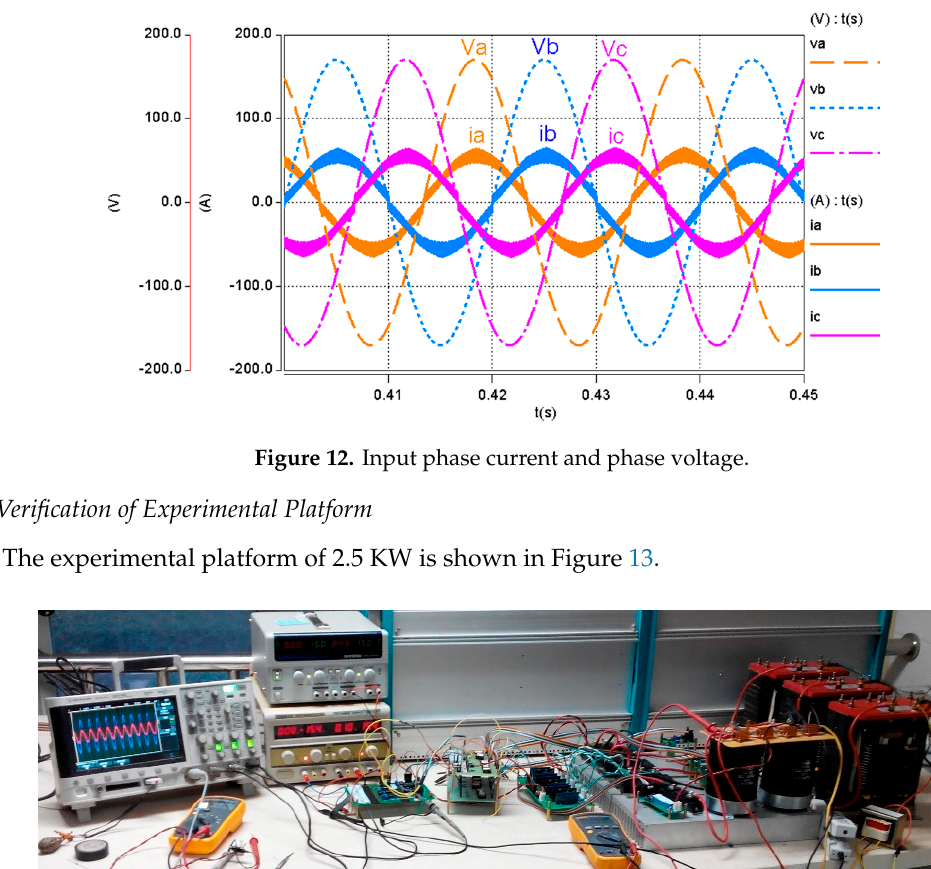
Figure 13. Experimental platform.